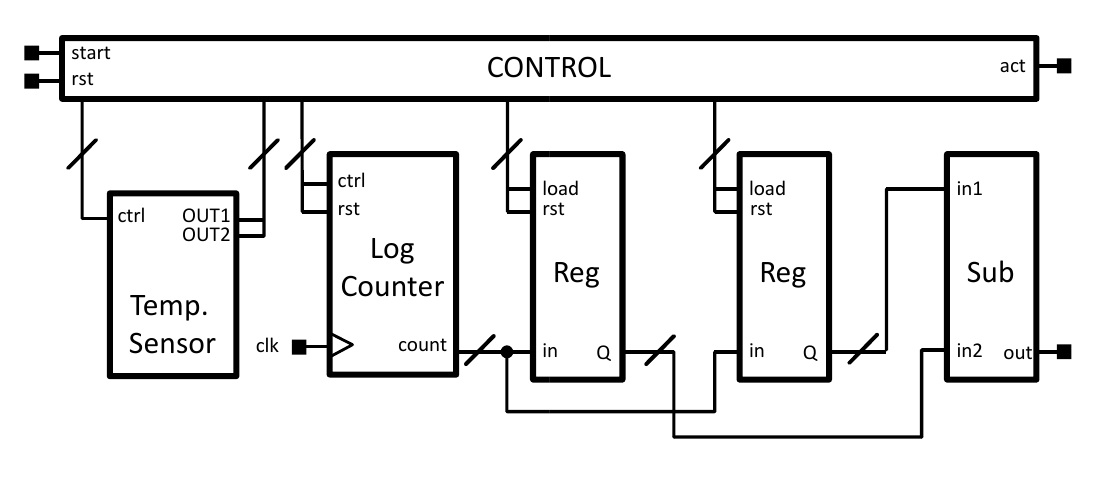
Figure 5. Constituent blocks of the 65 nm thermal